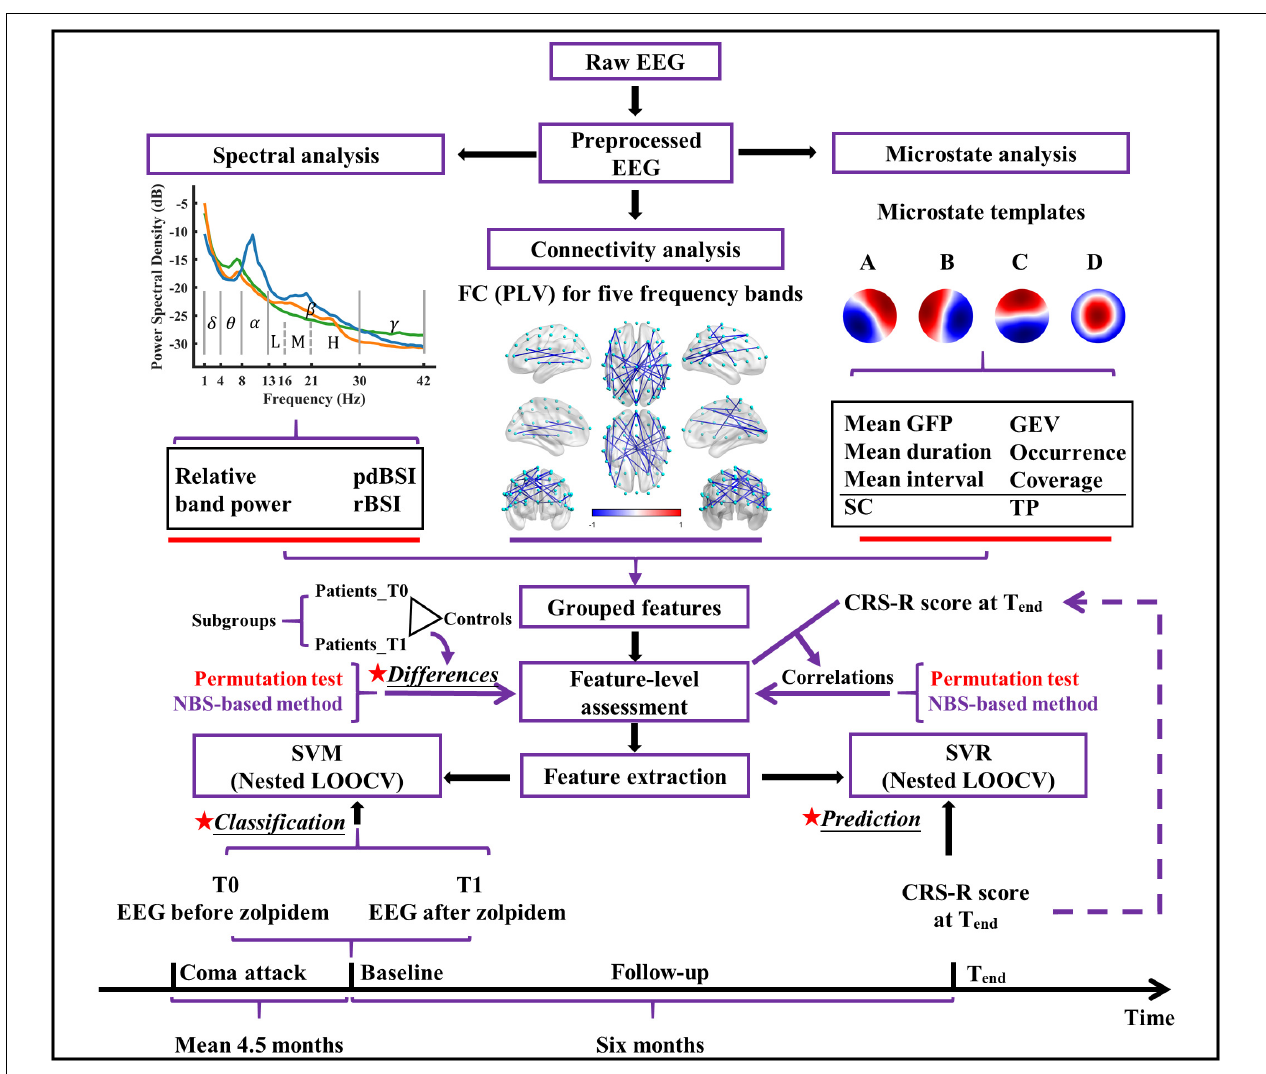
FIGURE 1 | The conceptual framework of the present study. pdBSI, pairwise-derived brain symmetry index; rBSI, revised brain symmetry index; FC, functional connectivity; PLV, phase locking value; GFP, global field power; GEV, global explained variance; SC, spatial correlation metric; TP, transition probability; NBS, network-based statistic; SVM, support vector machine; SVR, support vector regression; CRS-R, coma recovery scale-revised; LOOCV, leave-one-out